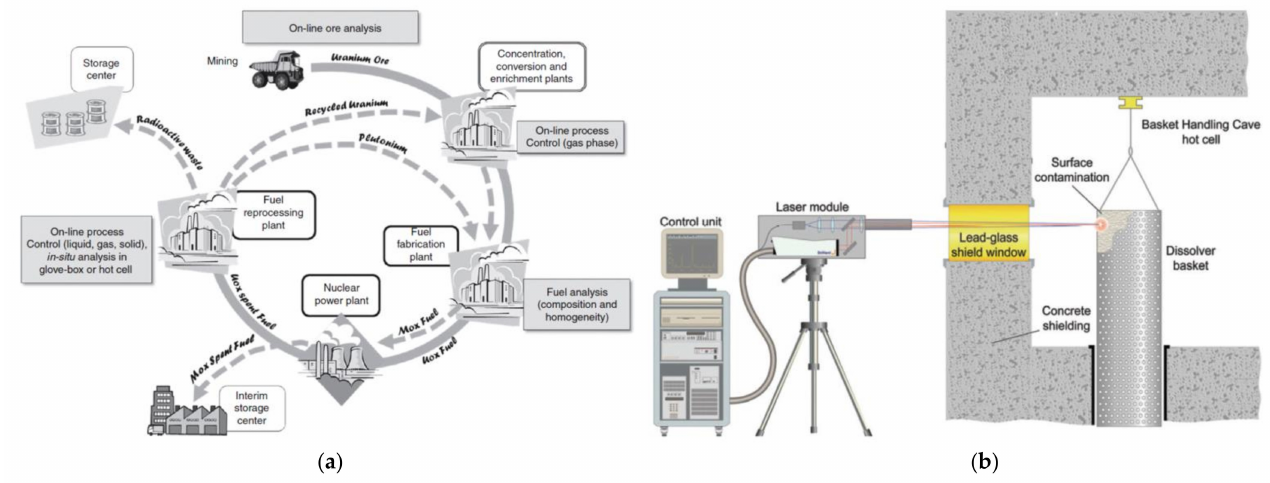
Figure 13. LIBS in nuclear materials analysis. ( a ) Potential applications of LIBS in nuclear fuel cycle. Adapted from [259]. ( b ) Schematic of a stand-off LIBS analyzer installed at the THORP nuclear plant in UK. Adapted from